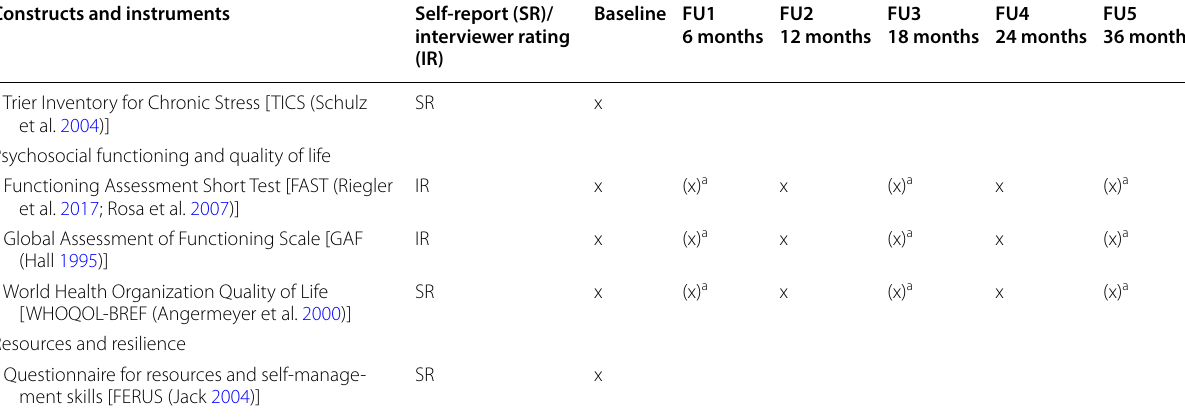
Observational outcomes: change in severity Diagnostic and dimensional instruments listed in Table